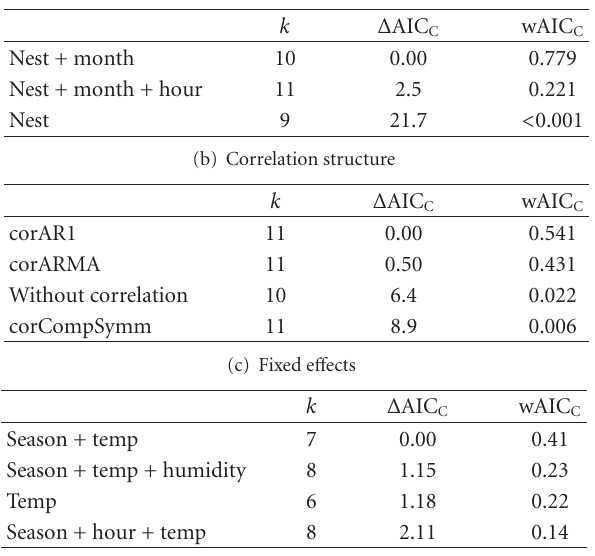
Table 2: Linear mixed e ff ects (LME) models performed between the number of wasps foraging in Polybia paulista and six explana- tory variables (temperature, humidity, luminosity, season, month, and hour). Tested models comparison: k = degree of freedom, Δ AIC = di ff erence in Akaike’s Information Criterion for each C model from the most parsimonious model, and wAICc = AICc weight.